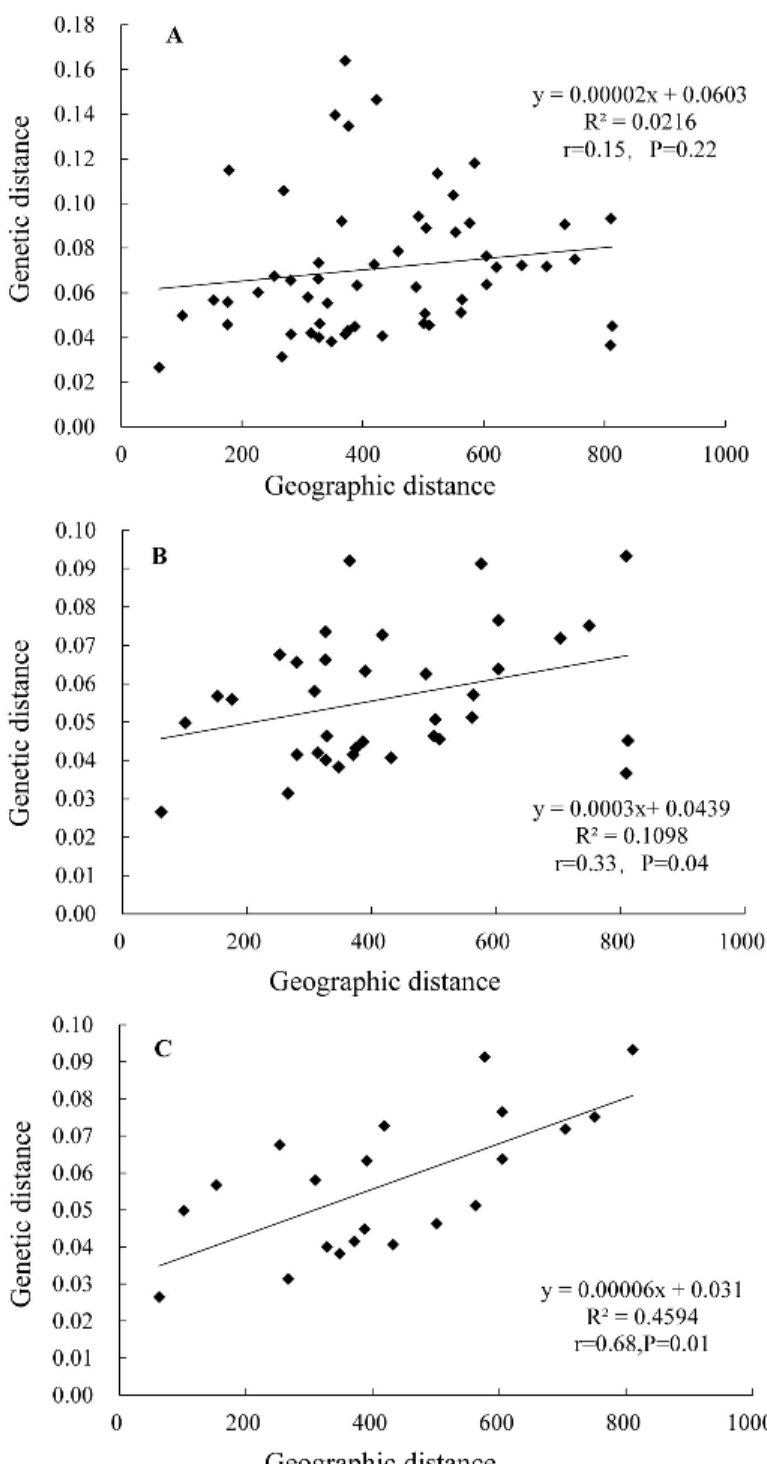
Figure 5. Correlation of genetic distance [ F ST /(1 − F ST )] with geographical distance (Km) of Chinese firs in different sampling localities. ( A ) The correlation of all 11 sampling localities. ( B ) The correlation of 9 sampling localities, excluding sampling localities of CW and PB. ( C ) The correlation of 7 sampling localities, excluding sampling localities of PG, JX, CW, and PB.